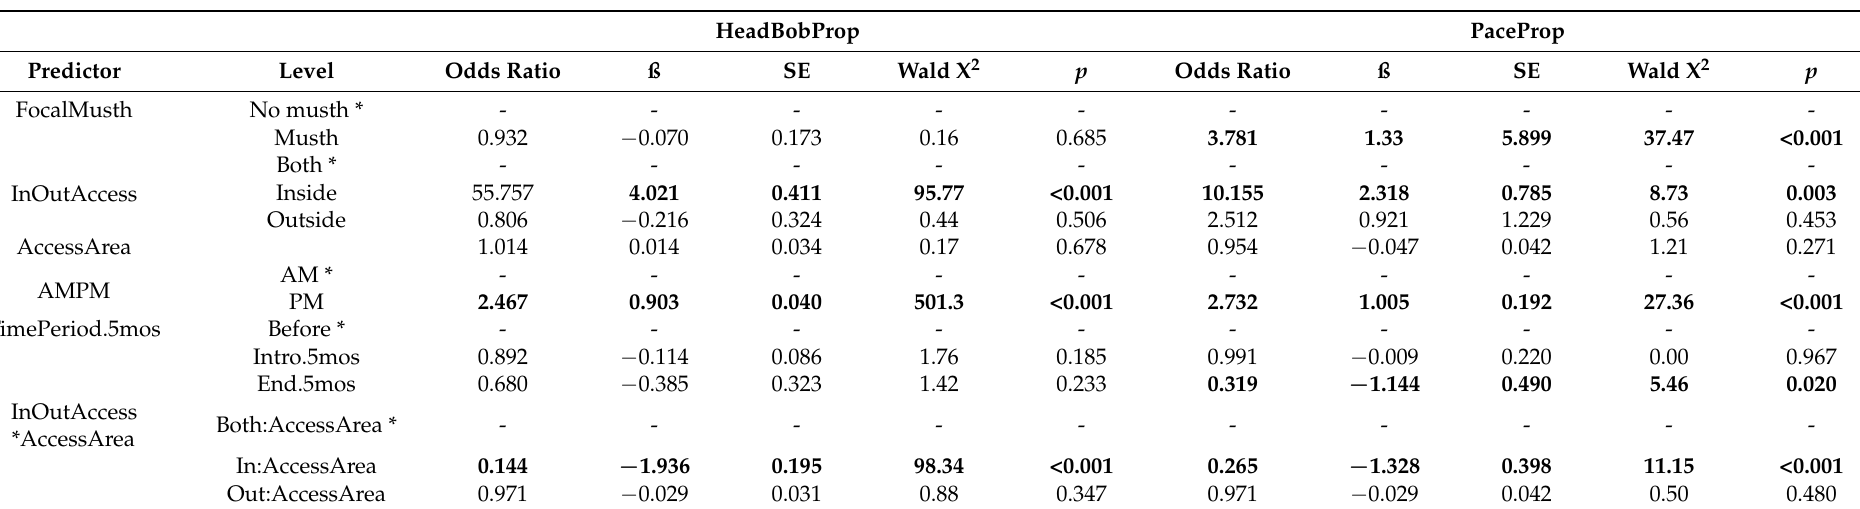
Table 8. GEE Model Parameter Estimates for Alone Data. Generalized Estimating Equation Results of Associations between Predictor Variables (Fixed Effects) and Stereotypic Behavioral Response